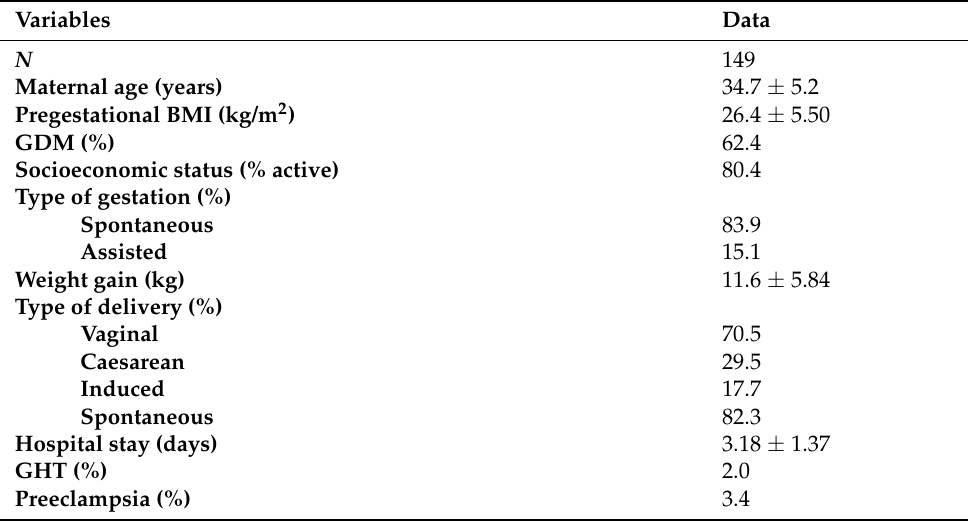
Table 1. Characteristics of the participants in this